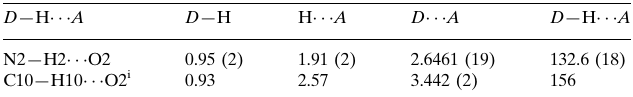
Hydrogen-bond geometry (A˚ , (cid:5) ).